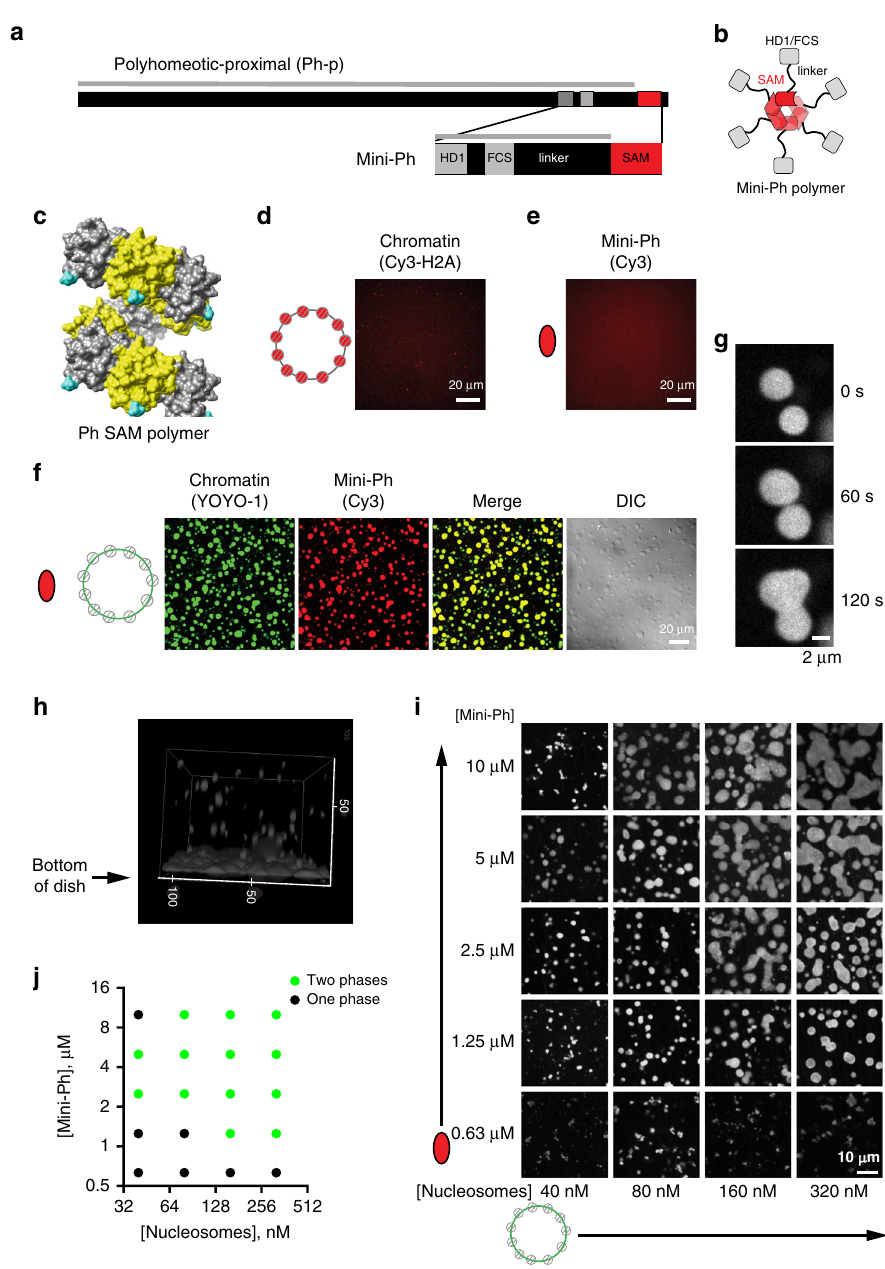
Fig. 1 Mini-Ph forms phase-separated condensates with chromatin. a Schematic of Polyhomeotic – proximal and Mini-Ph, which spans aa 1389 – 1577 and includes the 3 conserved domains and an unstructured linker. The gray line indicates predicted disordered sequence (using PONDR-VSL2) 92 . Note that 91.9% of the sequence is predicted to be disordered (disregarding segments less than 30 amino acids), with only the SAM predicted to be ordered. b Schematic depicting the oligomeric state of Mini-Ph, which forms limited polymers of 4 – 6 units (6 are shown) 5 . c Structure of nine units of the Ph SAM polymer demonstrating its helical architecture. The N terminus, from which the linker extends, is shown in cyan. PDB 1D 1KW4. d , e Neither chromatin ( d ) nor Mini-Ph ( e ) form condensates in buffer. f Mini-Ph forms phase-separated condensates with chromatin. This observation was repeated with three different preparations of Mini-Ph and more than ten different chromatin preparations. g Time lapse of droplet fusion of Mini-Ph-chromatin condensates, visualized with Alexa-647-labeled Mini-Ph. h 3D reconstruction of confocal stack of images demonstrating that Mini-Ph-chromatin condensates form a fused layer on the bottom of the imaging plate. Scale is in microns. i Representative images from a matrix of Mini-Ph and chromatin showing the relationship between protein and chromatin concentration and condensate formation. [Nucleosomes] assume 8 fmol of nucleosomes per 1 ng of DNA. Images are representative of two independent experiments. j Graph depicting the conditions where one phase and two phases were scored in two experiments like the one shown in ( i ). See also Supplementary Figs. 1 – 3 and Supplementary Movies 1 –